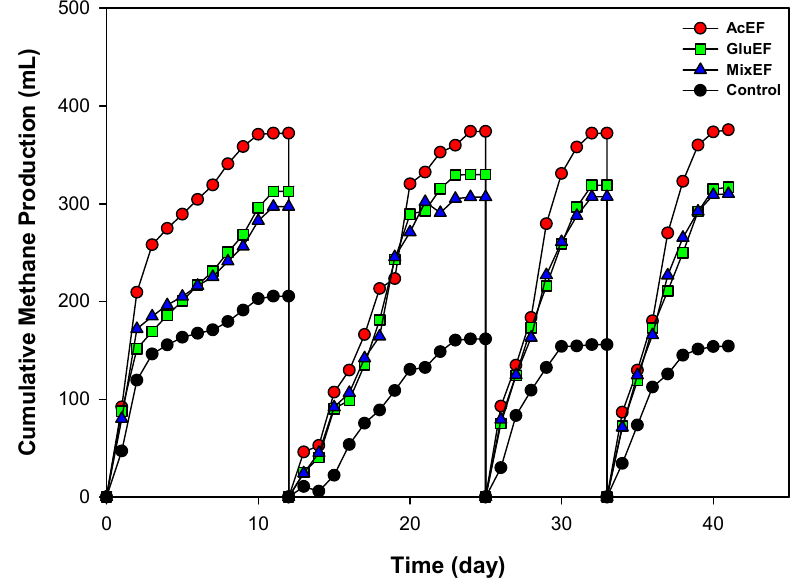
Figure 2. Cumulative methane production depending on the substrate type of the anaerobic reactor exposed to an electric field.